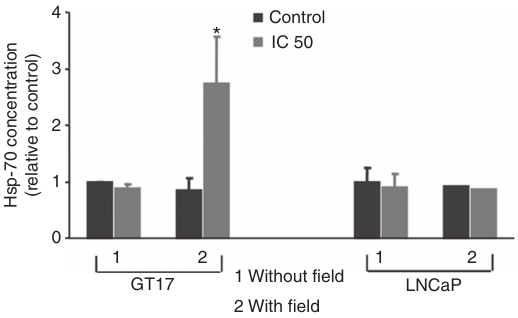
Figure 9 Expression of HSP70 in GT1-7 neurons and LNCaP cells following pretreatment with SPIONs@Au-LHRH and subsequent exposure to the magnetic field (465 Oe; 15 min). GT1-7 neurons and LNCaP cells were pretreated with 100 or 250 μ g/ml of SPIONs@ Au-LHRH for 24 h and then exposed to the magnetic field. The levels of HSP70 were measured based on a sandwich ELISA as described in the Methods section. The control assays used cells that were not exposed to SPIONs@Au-LHRH and subsequent exposure to the magnetic field. Data shown are the fold increase in the expression of HSP70 relative to the respective control(s). Values presented are mean ± SD of three to five independent experiments (* and ** indi- cate significance at p < 0.05 and p < 0.01 versus untreated